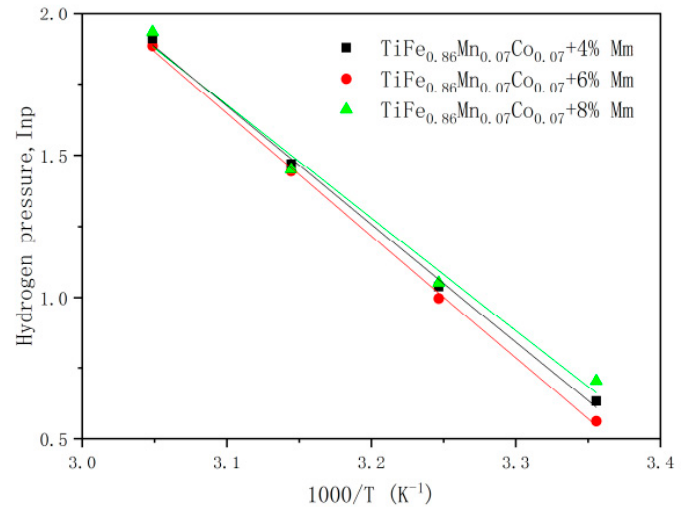
Figure 4. Van’t Ho ff plots of TiFe 0.86 Mn 0.07 Co 0.07 + x% Mm (x = 4,6,8) Figure 4. Van’t Hoff plots of TiFe 0.86 Mn 0.07 Co 0.07 + x% Mm (x = 4,6,8) alloys.